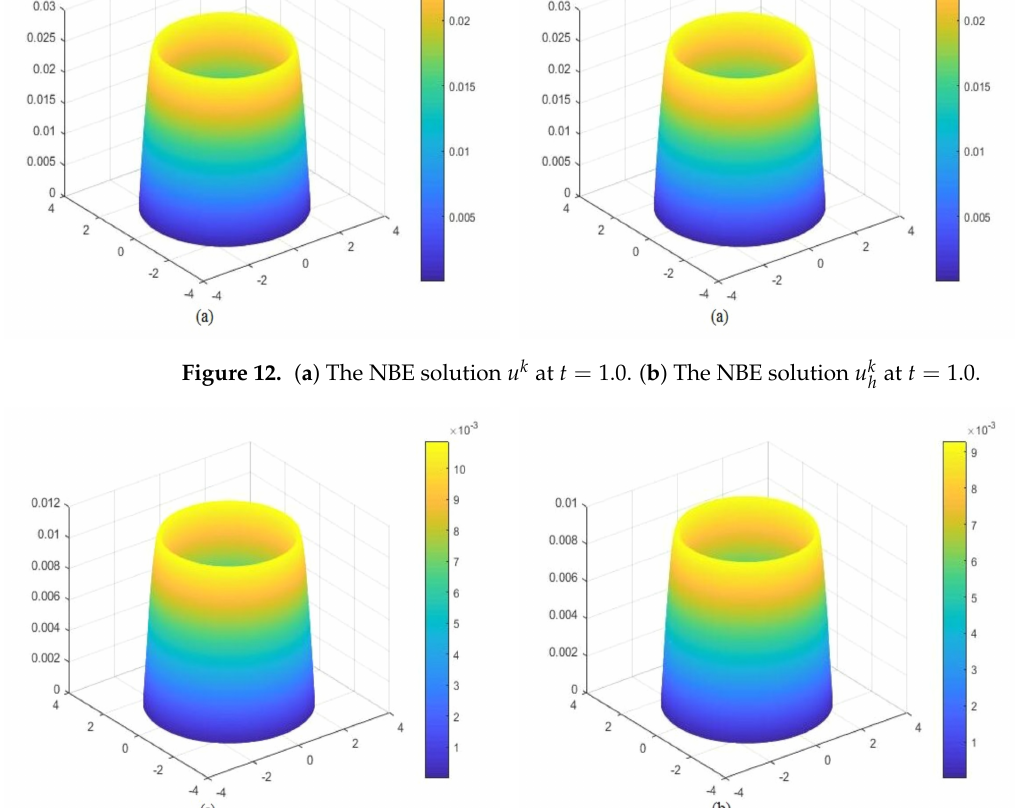
Figure 13. ( a ) The NBE solution u k at t = 1.2. ( b ) The analytical solution u k